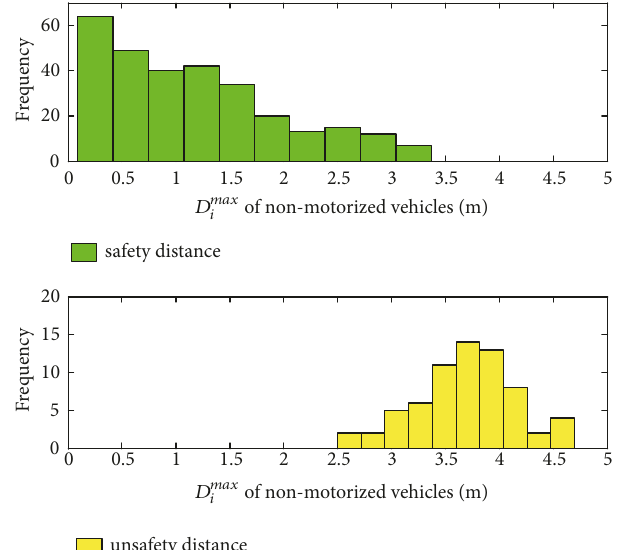
Figure 6: Histograms of the safe and unsafe occurrences with respect to the 𝐷 𝑚𝑎𝑥 𝑖 of nonmotorized vehicles at the Changji-Moyu intersection.